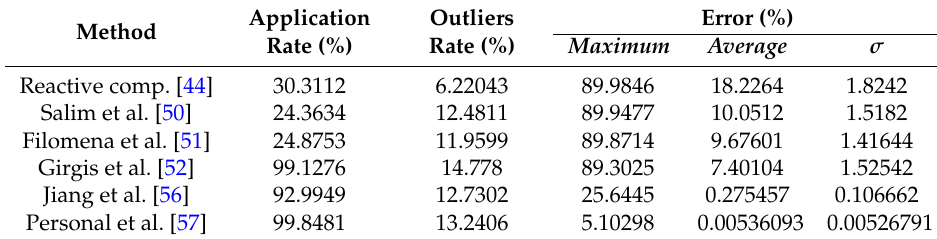
Table 3. Global result